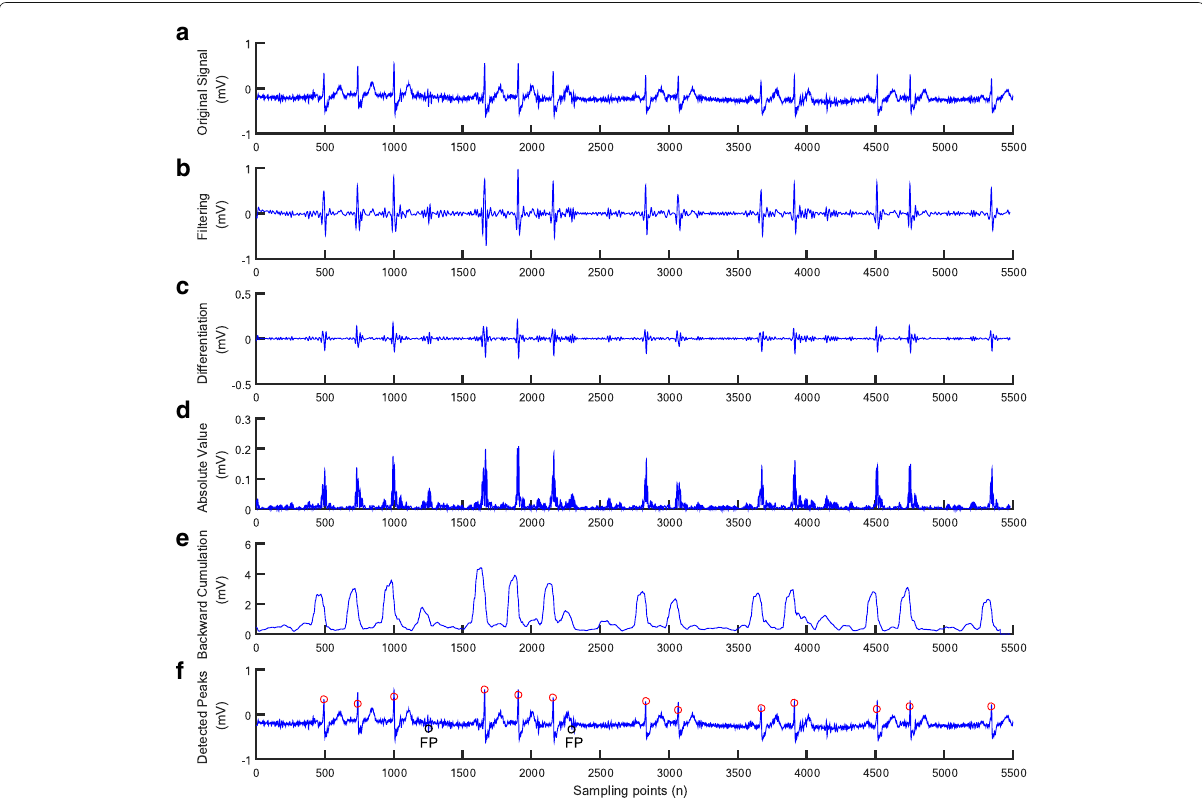
Fig. 6 Results after performing each stage of the method for the ECG with numerous long time cardiac arrest in duration (ECG recording 232). a ) Original signal. b ) Filtering. c ) Differentiation. d ) Absolute value. e ) Backward cumulation. f ) Detected peaks